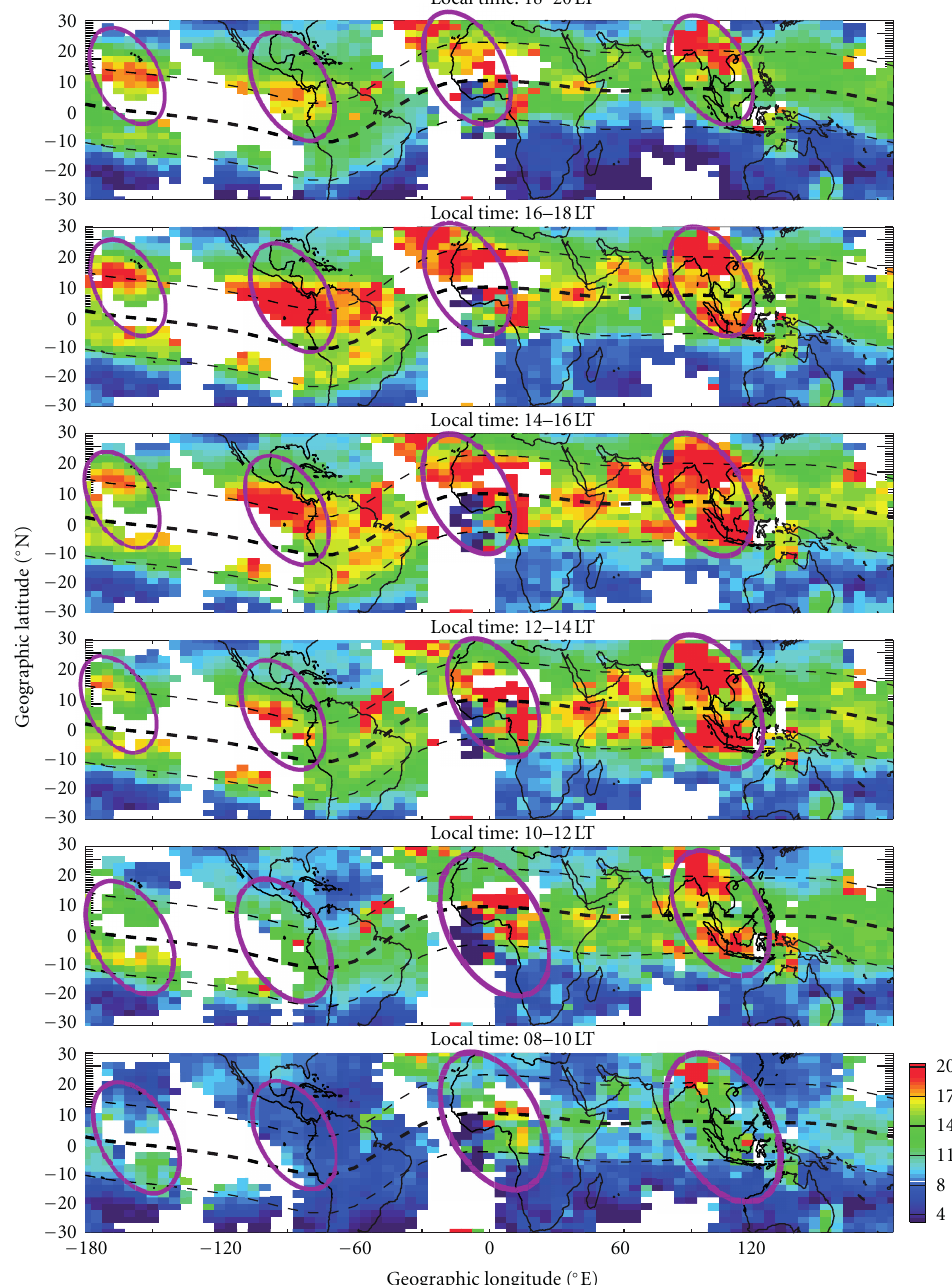
Figure 1: 2D (latitude/longitude) plot of the global two-month average GPS TEC distribution during magnetically quiet periods ( K p ≤ 3) in July and August 2008. Each panel represents di ff erent local time sector shown at the top of each panel. The horizontal bold and faint dashed lines represent the geomagnetic equator and the equatorial anomaly peak region,